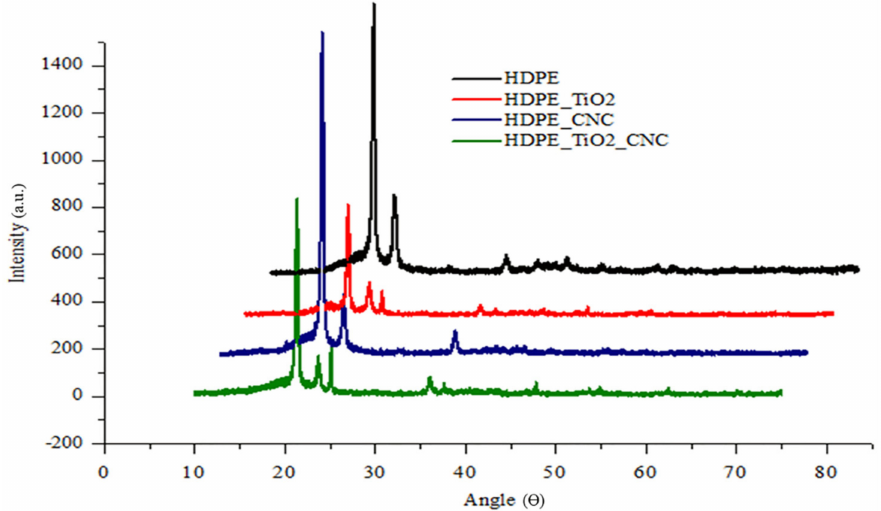
Figure 6. XRD diffractograms of the pure HDPE and HDPE nanobiocomposites.